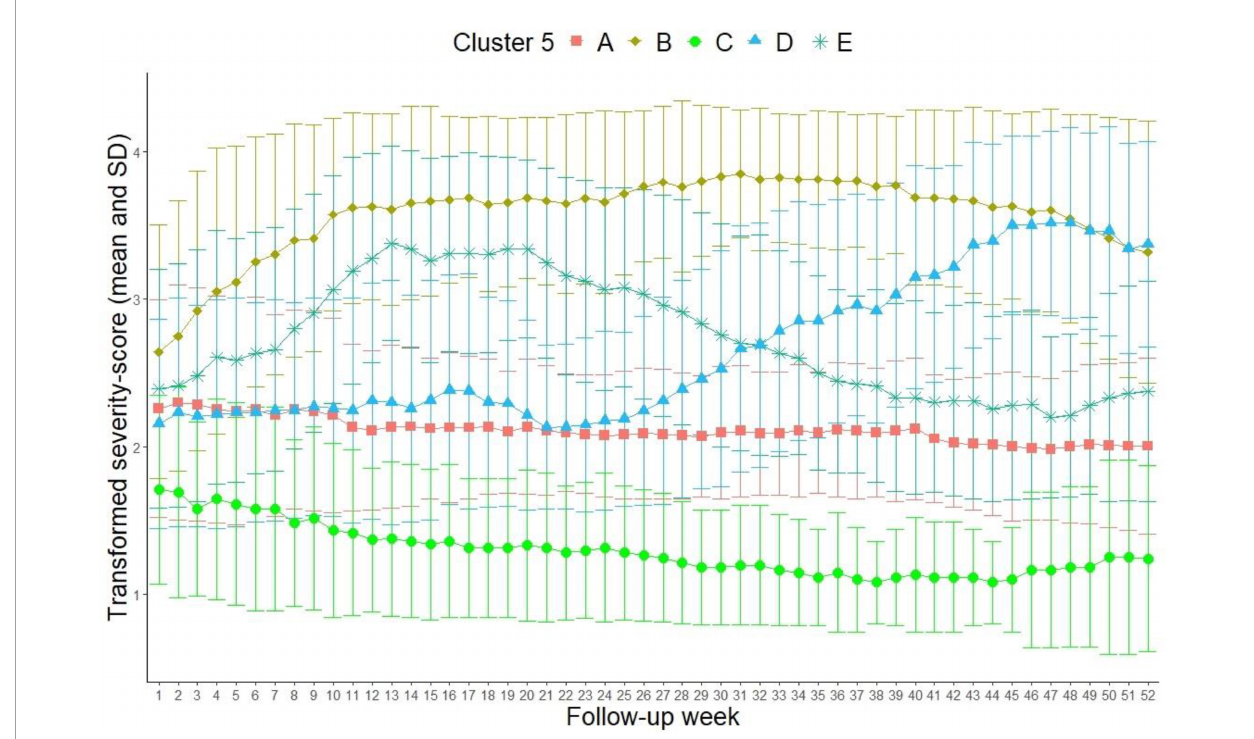
FIGURE4 5-cluster solution (Transformed severity score out of LIFE MDE 6-point scale: 1 = 1 in MDE 6-point scale = healthy, 2 = 2 and 3 in MDE 6-point scale = residual symptoms and partial remission, 3 = 4 in MDE 6-point scale = depressive symptomatology without meeting full diagnostic criteria, 4 = 5 and 6 in MDE 6-point scale = meeting diagnostic criteria for unipolar depression and showing possible psychotic symptoms or extreme